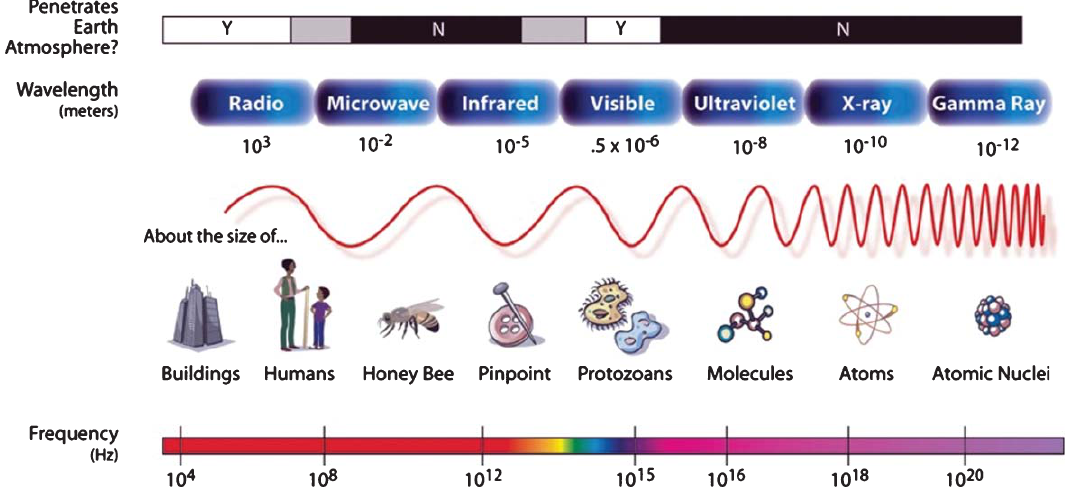
Fig. 1. The electromagnetic spectrum (NASA stock